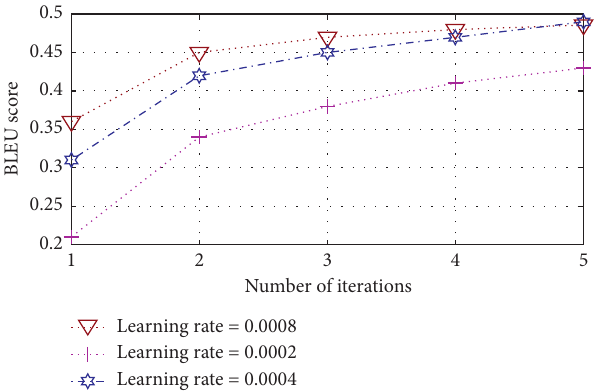
Figure 9: Comparison of BLEU scores under different learning rates.